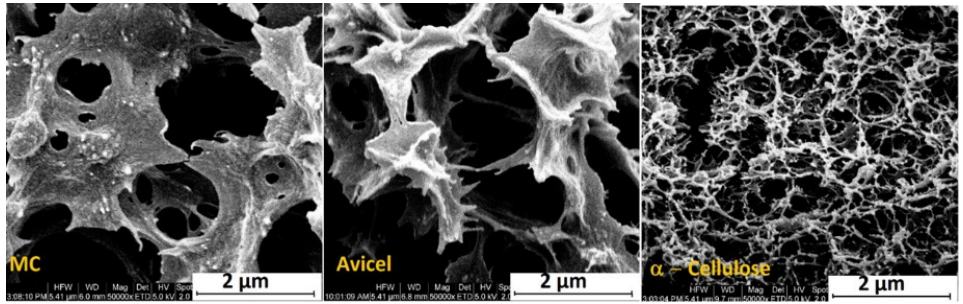
Figure 4. Influence of the cellulose type on the porous film structure (cross-section of 8 wt % cellulose-based films) [66]. Reprint with permission from ACS.